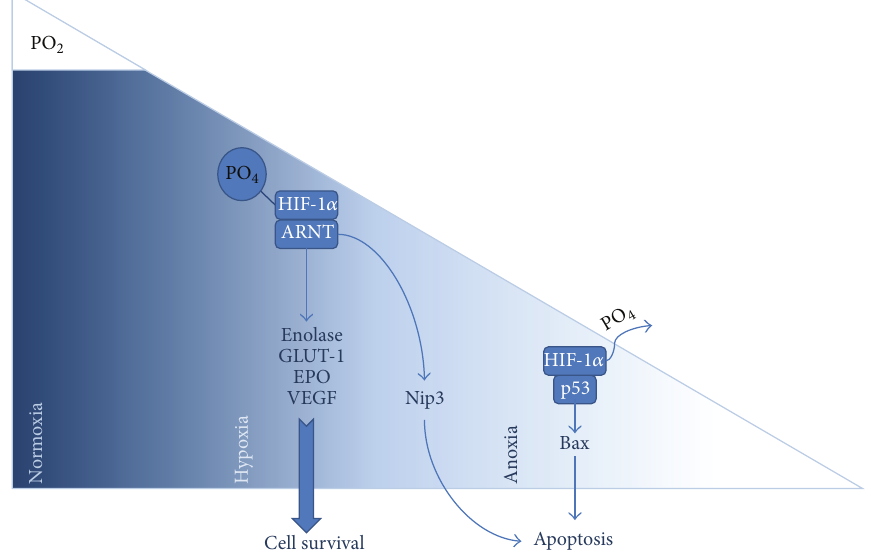
Figure 1: Sketch of hypoxia induced pathways mediated by HIF-1 𝛼 , leading to either cell survival or apoptosis [31].